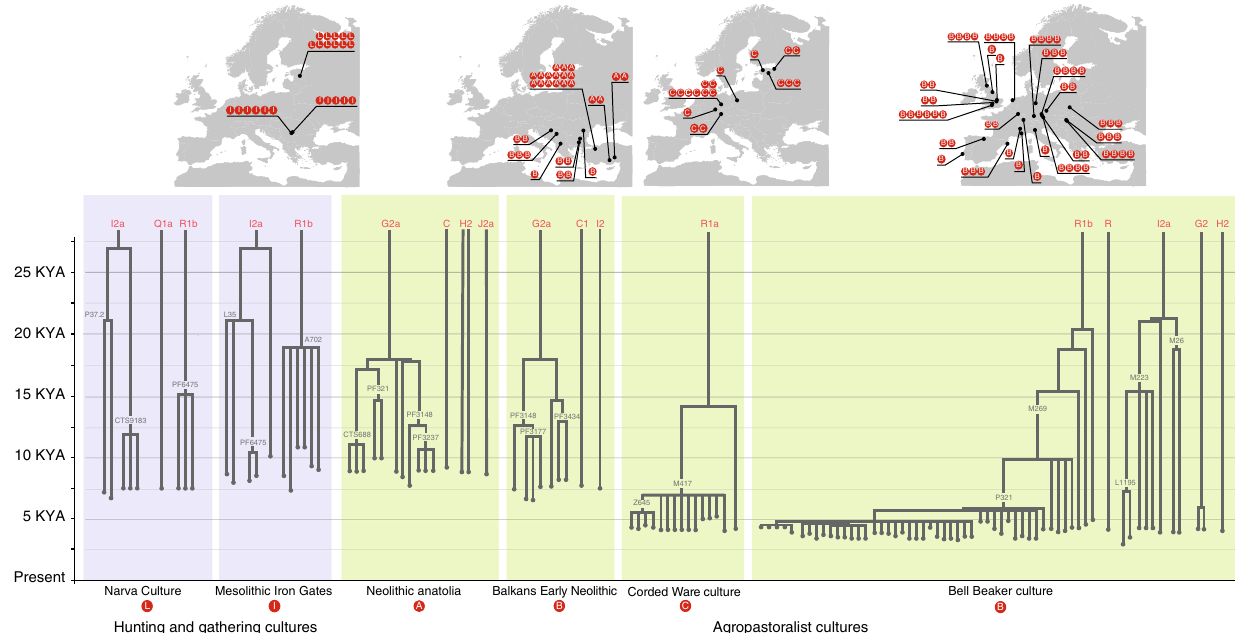
Fig. 6 Tree of Y-chromosome genotypes from samples found among cultures with hunter-gatherer subsistence, and agropastoralist subsistence. The blue background represents hunter-gatherer subsistence while the green background represents agropastoralist subsistence. Letters in red circles match individuals from sites with their archaeological context. Note that R1b-P321 is synonymous with R1b-S116. Adapted from Figs. 3, 4, 5 and 6 of Kivisild 67 , with addition of information from Olalde et al. 64 . The vertical axis represents time; the position of branch points represent the ages of branch-de fi ning mutations, with nomenclature and age from yfull